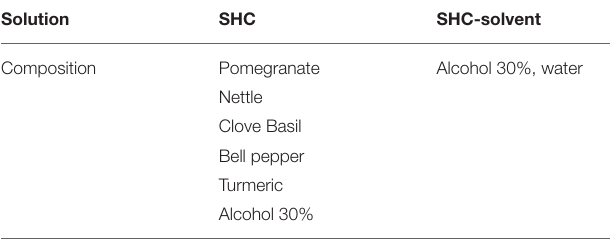
TABLE 1 | Composition of SHC and SHC solvent.